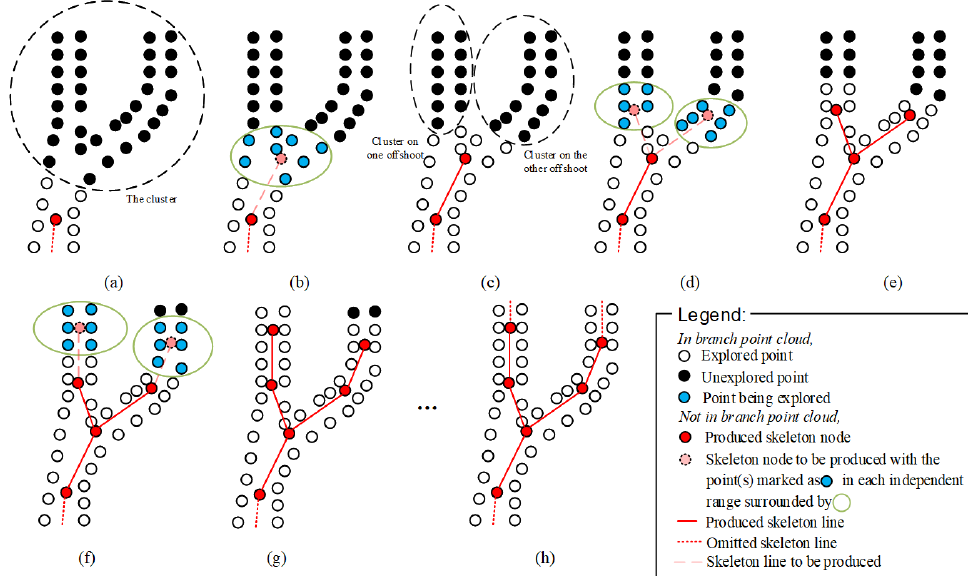
Figure 5. The execution